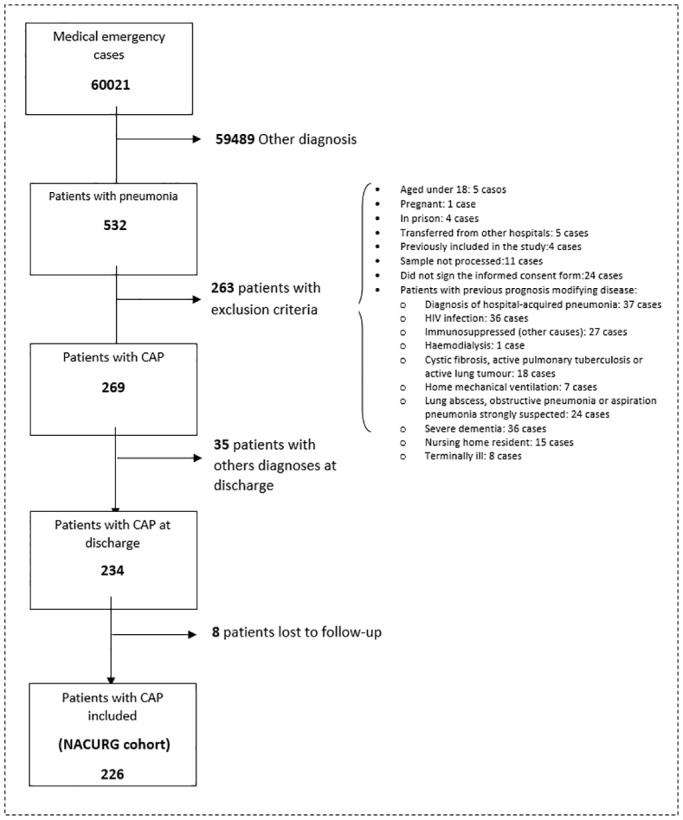
Patients included in the study.